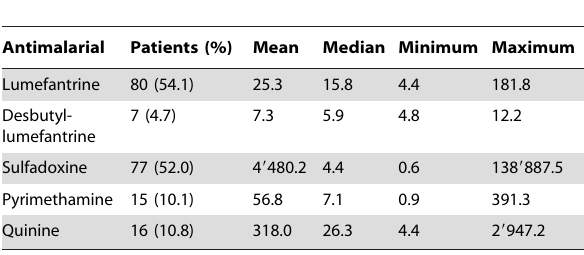
Table 3. Residual plasma concentrations of antimalarials found prior to treatment in 148 malaria patients [ng/mL].